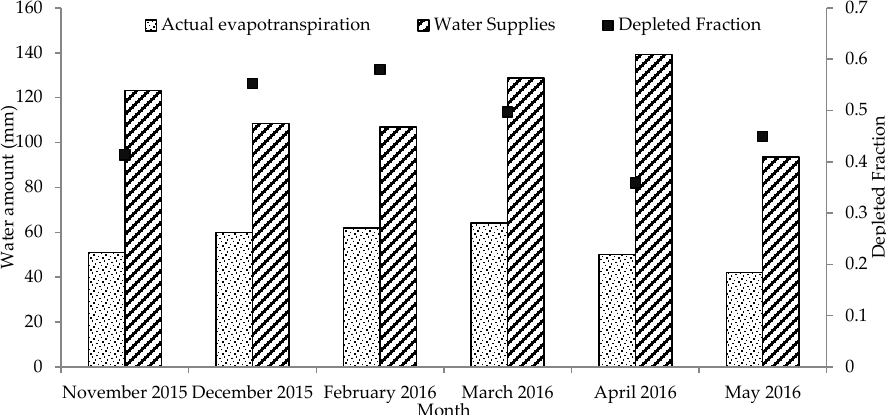
Figure 7. The actual evapotranspiration ( ET c ), water supplies, and depleted fraction ( DF ) of the study area during the winter season (from November 2015 to May 2016).